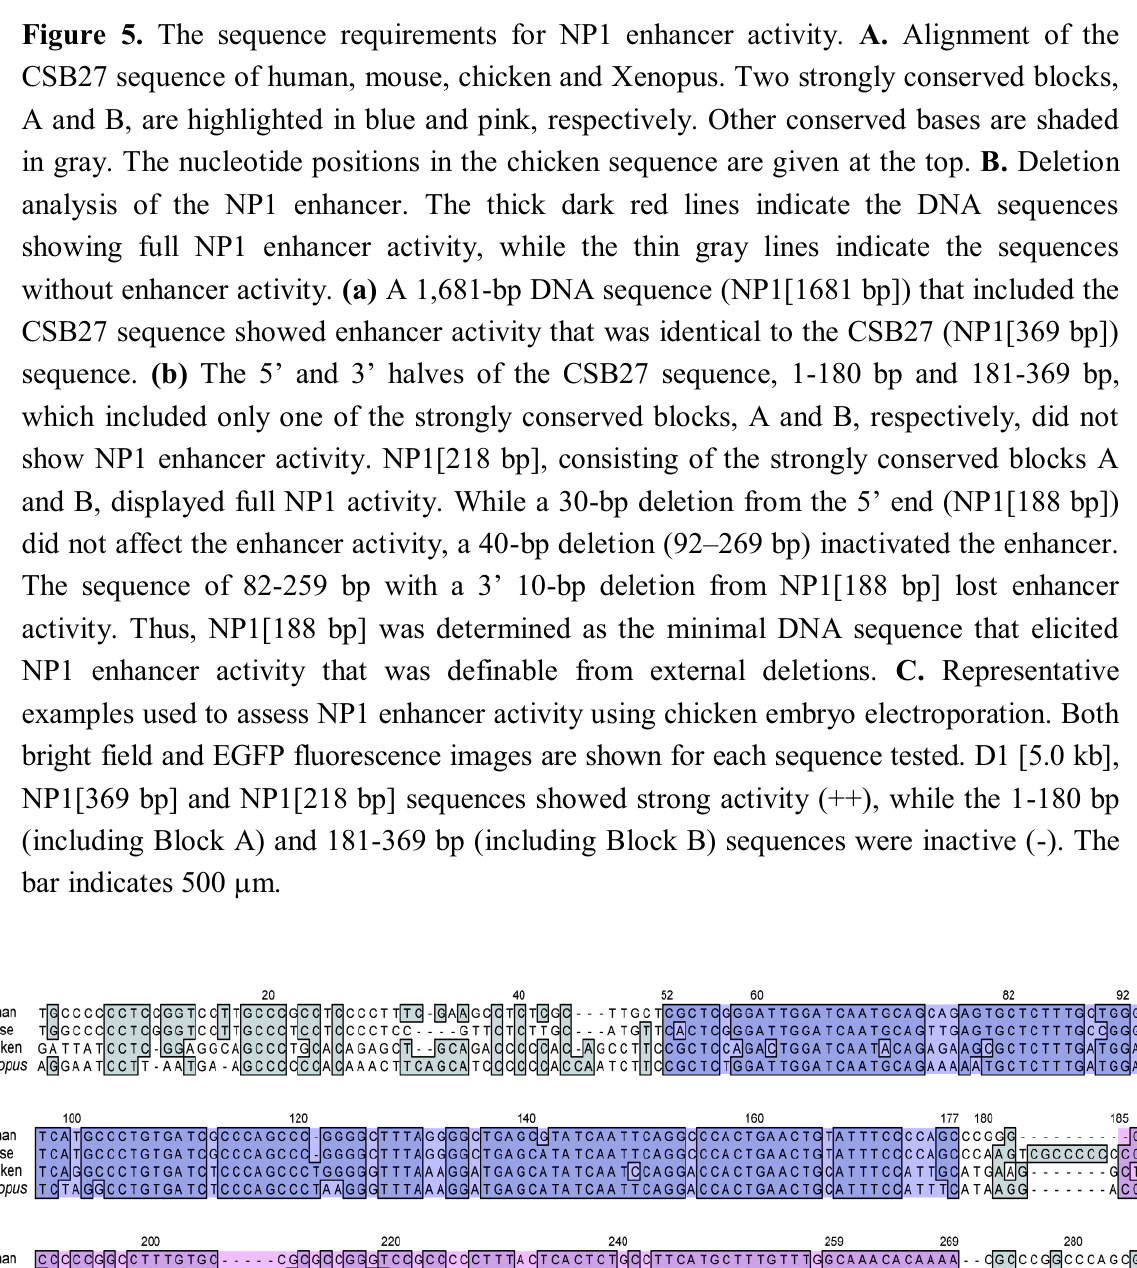
Figure 5. The sequence requirements for NP1 enhancer activity. A. Alignment of the CSB27 sequence of human, mouse, chicken and Xenopus. Two strongly conserved blocks, A and B, are highlighted in blue and pink, respectively. Other conserved bases are shaded in gray. The nucleotide positions in the chicken sequence are given at the top. B. Deletion analysis of the NP1 enhancer. The thick dark red lines indicate the DNA sequences showing full NP1 enhancer activity, while the thin gray lines indicate the sequences without enhancer activity. (a) A 1,681-bp DNA sequence (NP1[1681 bp]) that included the CSB27 sequence showed enhancer activity that was identical to the CSB27 (NP1[369 bp]) sequence. (b) The (cid:24)(cid:182)(cid:3) (cid:68)(cid:81)(cid:71)(cid:3) (cid:22)(cid:182)(cid:3) (cid:75)(cid:68)(cid:79)(cid:89)(cid:72)(cid:86)(cid:3) (cid:82)(cid:73)(cid:3) (cid:87)(cid:75)(cid:72)(cid:3) (cid:38)(cid:54)(cid:37)(cid:21)(cid:26)(cid:3) (cid:86)(cid:72)(cid:84)(cid:88)(cid:72)(cid:81)(cid:70)(cid:72)(cid:15)(cid:3) (cid:20) -180 bp and 181-369